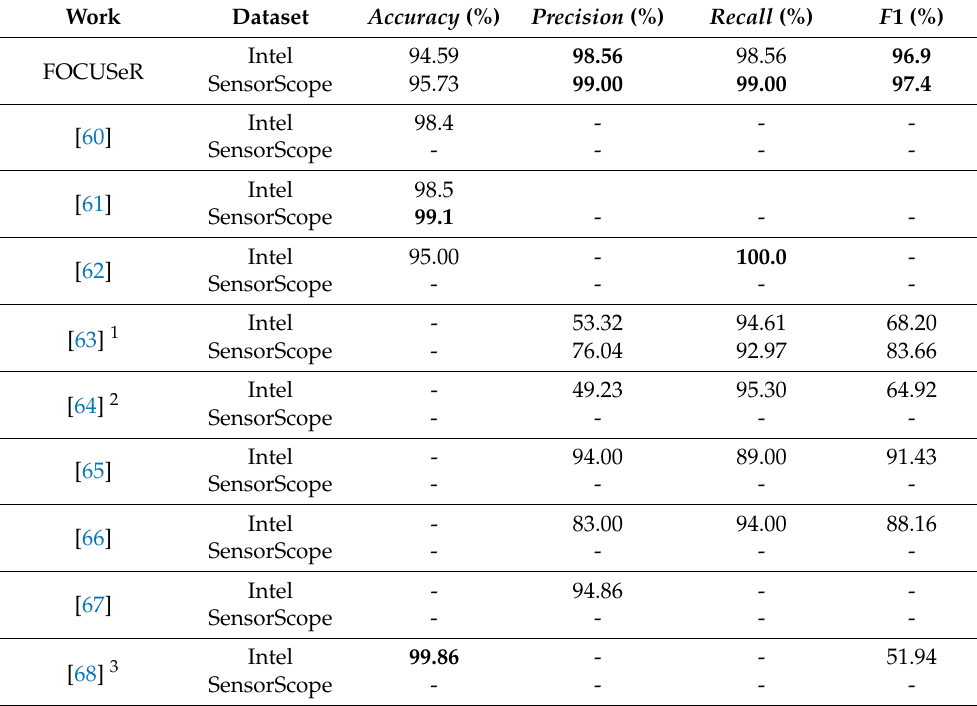
Table 7. Comparison of Effectiveness Evaluation (best results for each metric are highlighted in bold).